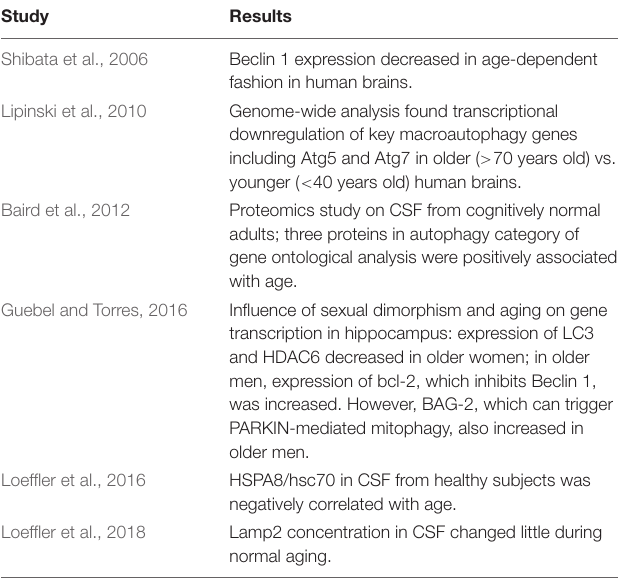
TABLE 1 | Influence of normal aging on autophagy in human brain and CSF. Study